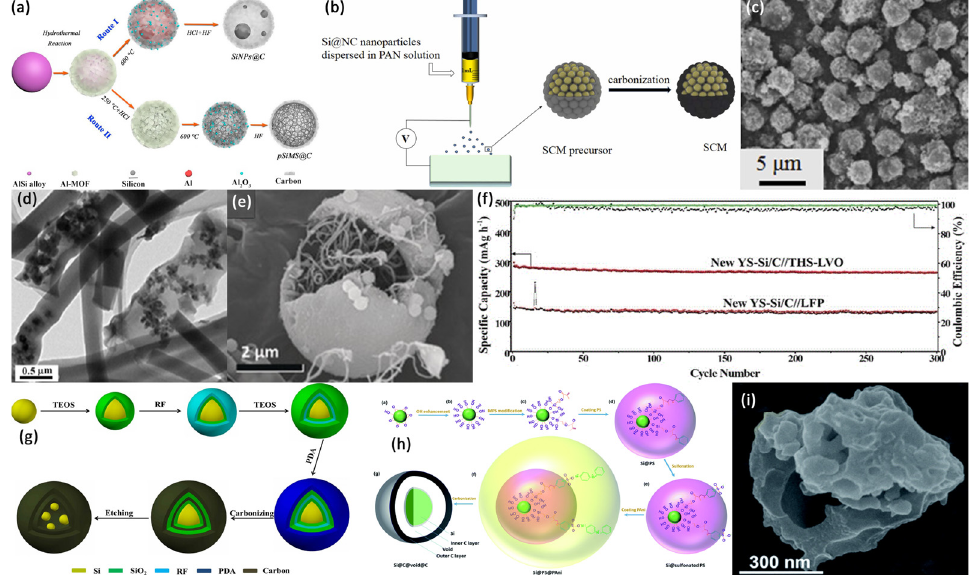
Figure 1. ( a ) Schematic illustration for the fabrication of SiNPs@C (Route I) and pSiMS@C (Route II) core-shell composites using SiAl@Al-MOF as the precursor. Reproduced with permission [58]. Cop- yright 2018, Elsevier. ( b ) Schematic diagram of SCM composite by electrospray technique, and ( c ) SEM image of SCM. Reproduced with permission [59]. Copyright 2022, Elsevier. ( d ) TEM image of SC-NF. Reproduced with permission [61]. Copyright 2021, ACS Publications. ( e ) SEM image of YS- Si/C anode, and ( f ) rate performance of the full cells of YS-Si/C anode//LFP. Reproduced with per- mission [62]. Copyright 2019, Wiley Online Library. ( g ) Schematic illustration of the preparation process of YS-Si/C composites. Reproduced with permission [63]. Copyright 2019, Elsevier . ( h ) Schematic illustration of the synthesis of the Si@C@viod@C, and ( i ) SEM image of Si@C@void@C. Reproduced with permission [64]. Copyright 2018, Royal Society of Chemistry.